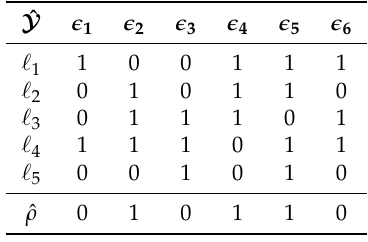
Table 7. Level soft set L ( ˆ Γ ; med